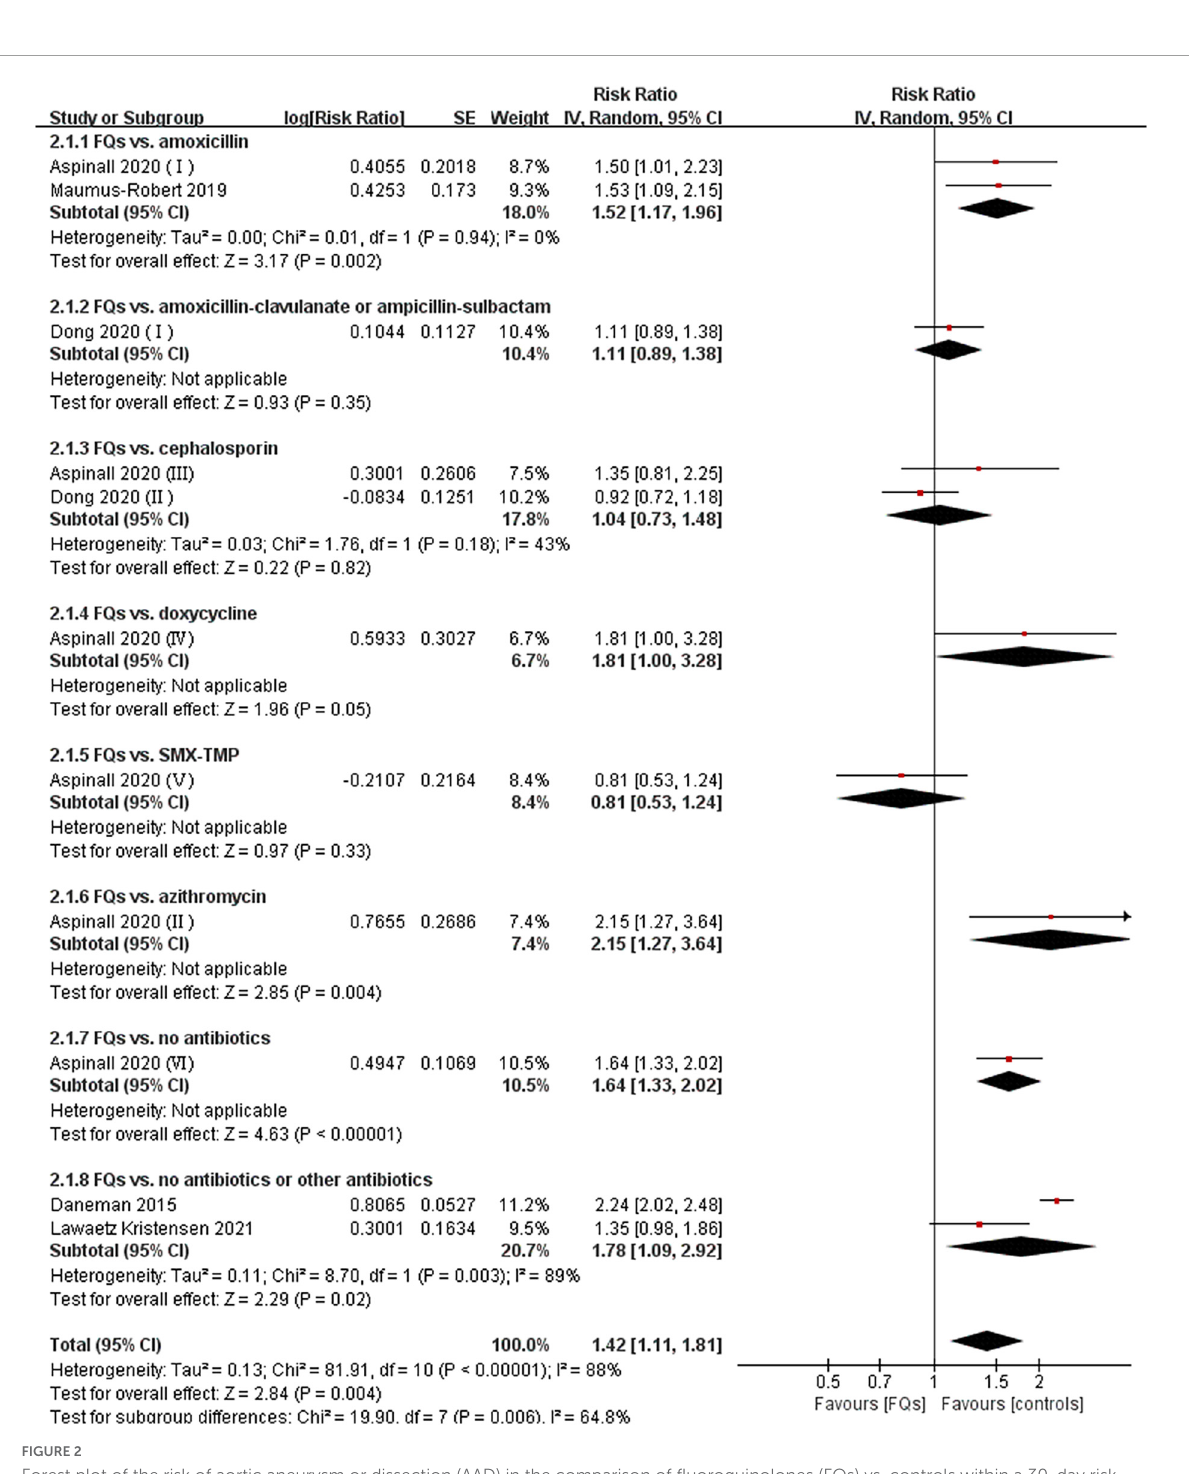
FIGURE2 Forest plot of the risk of aortic aneurysm or dissection (AAD) in the comparison of fluoroquinolones (FQs) vs. controls within a 30-day risk period. FQs, fluoroquinolones; SMX-TMP, combined trimethoprim and sulfamethoxazole; IV, inverse variance; CI, confidence interval.